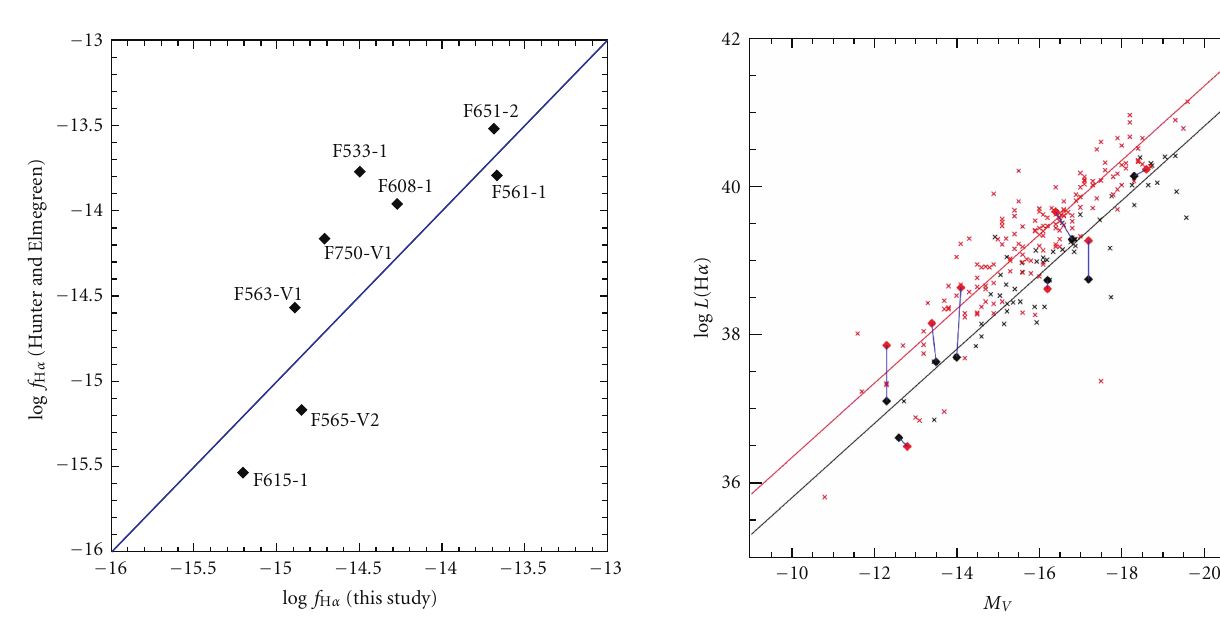
Figure 10: Correlation between stellar mass (absolute magnitude) and H α luminosity. The black symbols are this paper LSB sample. The red symbols are the combined samples of Van Zee, Hunter and Elmegreen (there was no statisical di ff erence between those two samples). The eight galaxies in common with Hunter and Elmegreen are shown as solid symbols (connected for their di ff ering H α values). The LSB galaxies are about 0.5 log L (H α ) fainter per stellar mass than the dwarf irregular samples, and there is no indication this is due to improper H α